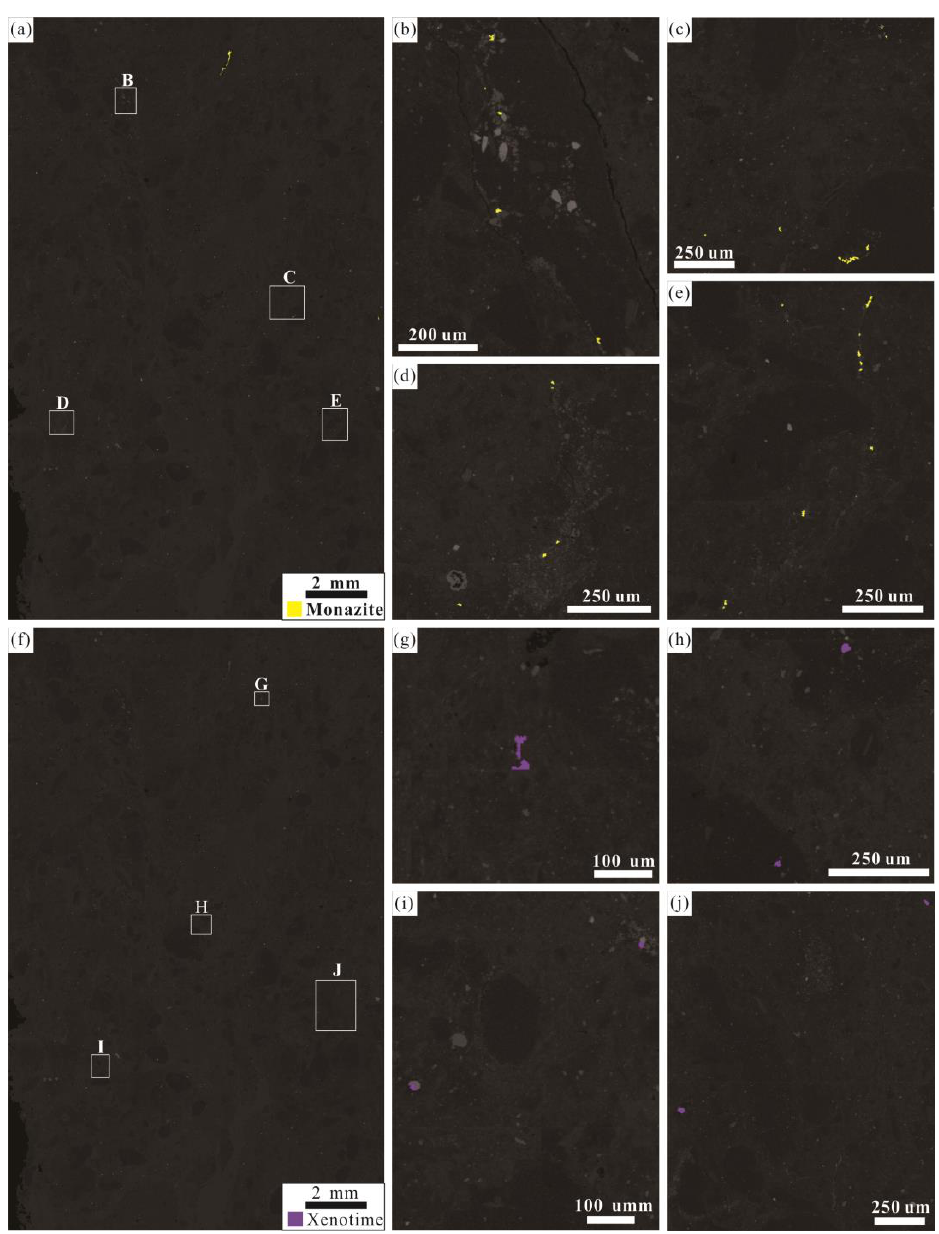
Figure 8. BSE images of monazite and xenotime from the Lindai bauxite ore obtained by TIMA mineral scanning. ( a – e ) Monazite and ( f – j ) xenotime.